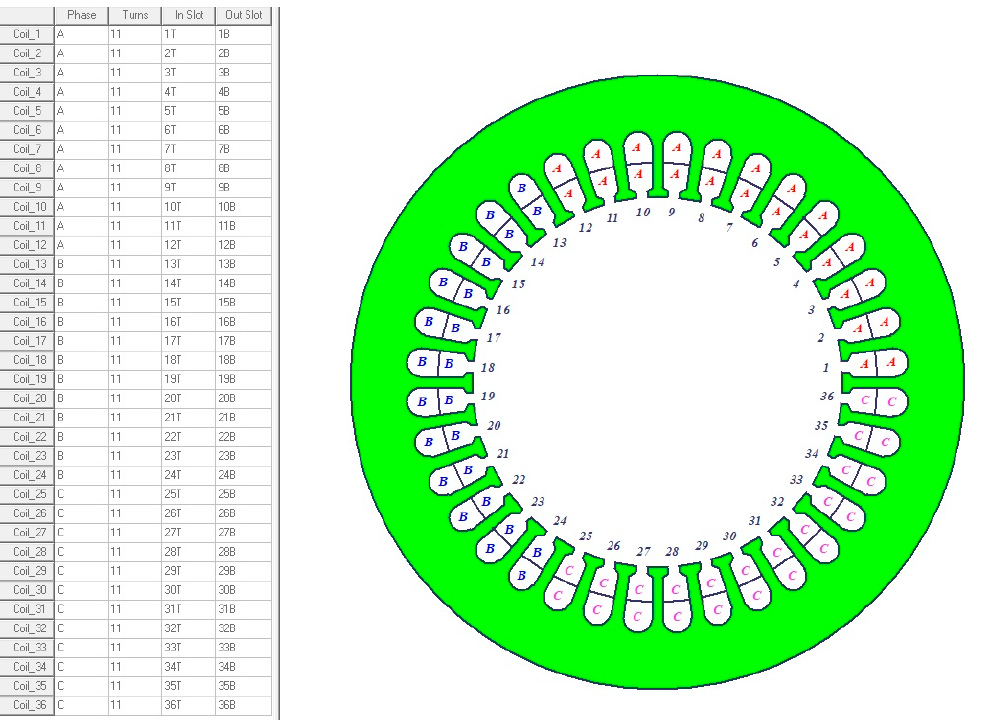
Figure 8. Stator and rotor in RMxprt.